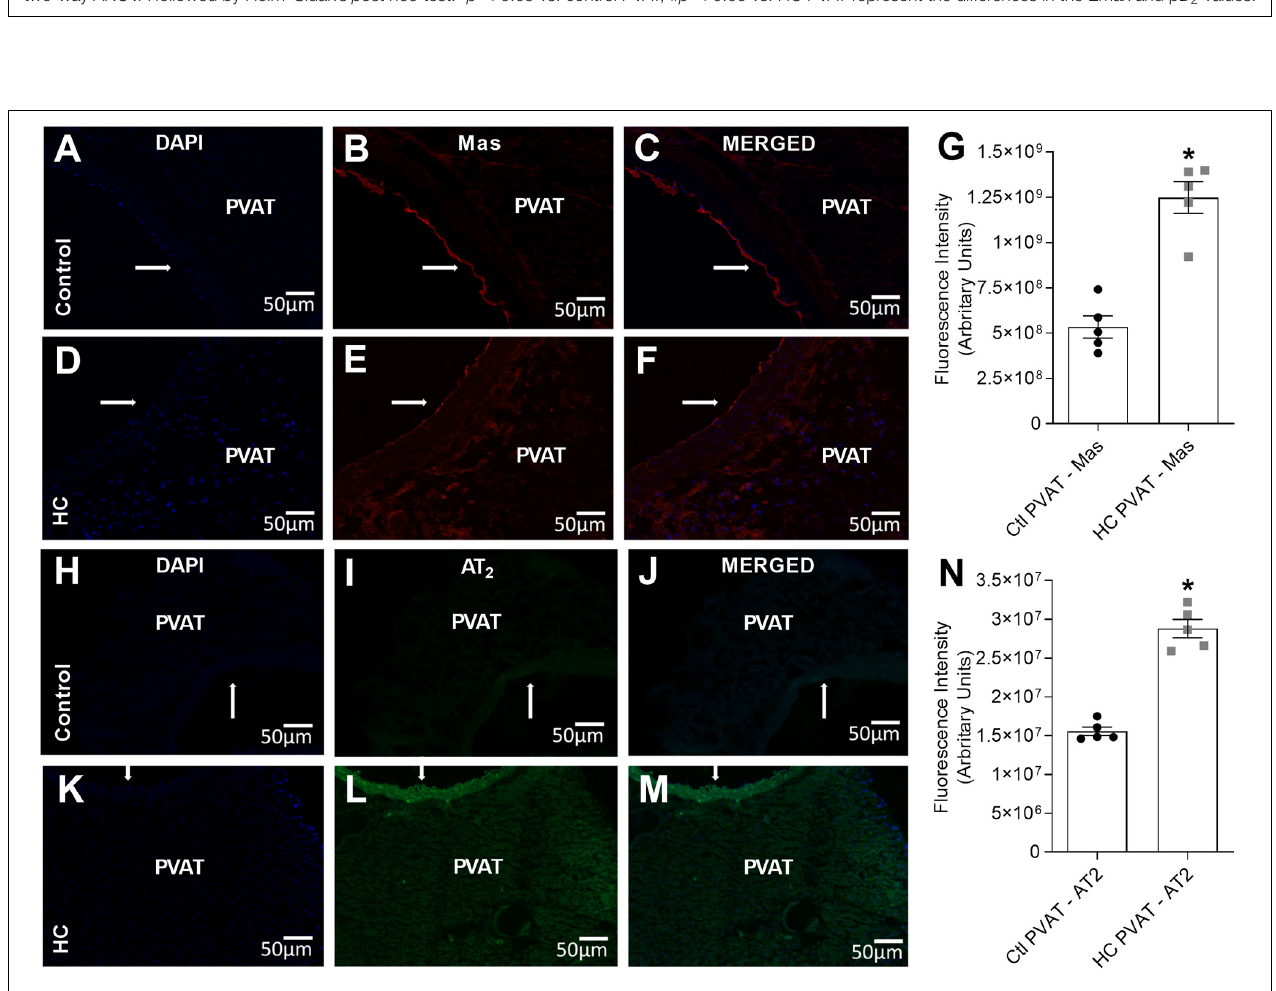
FIGURE 6 | Immunofluorescence of Mas and AT 2 receptors in the PVAT of control and HC groups. (A,D,H,K) Nuclear immunostaining with DAPI. Immunostaining for (B,E) Mas or (I,L) AT 2 receptors. Overlap of immunostaining for (C,F) Mas receptors and DAPI or (J,M) AT 2 receptors and DAPI. Fluorescence intensity emitted by binding the selective secondary antibody to (G) Mas (red fluorescence) or (N) AT 2 (green fluorescence) receptors in the PVAT, respectively, were represented in graphical bars with mean ± SEM. The total number of animals required to carry out the experiments in each group ( n ) is presented in the dispersion points in the graphs. Statistical significance was determined using Student’s t -test. * p < 0.05 vs. control. Arrows indicate the location of the endothelial layer of blood vessels. Scale bars indicate 50 µ m.